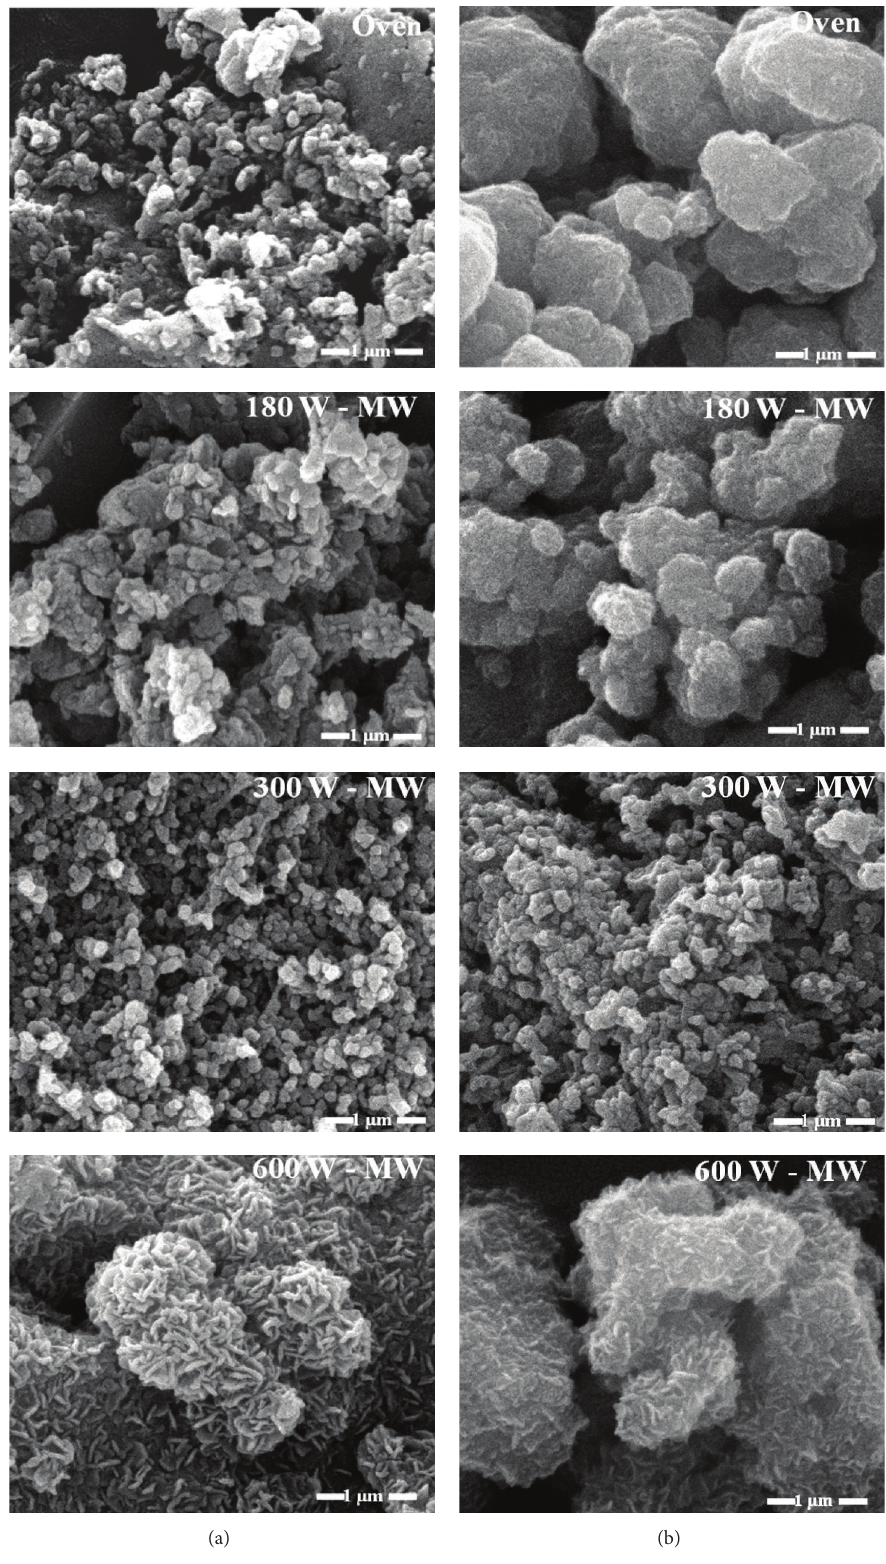
Figure 5: SEM micrographs of vanadium oxide powders prepared by the oven heating at 100 ∘ C and the microwave heating at different microwave irradiation powers 180–600 W for 15min and then calcined at (a) 400 ∘ C and (b) 500 ∘ C for